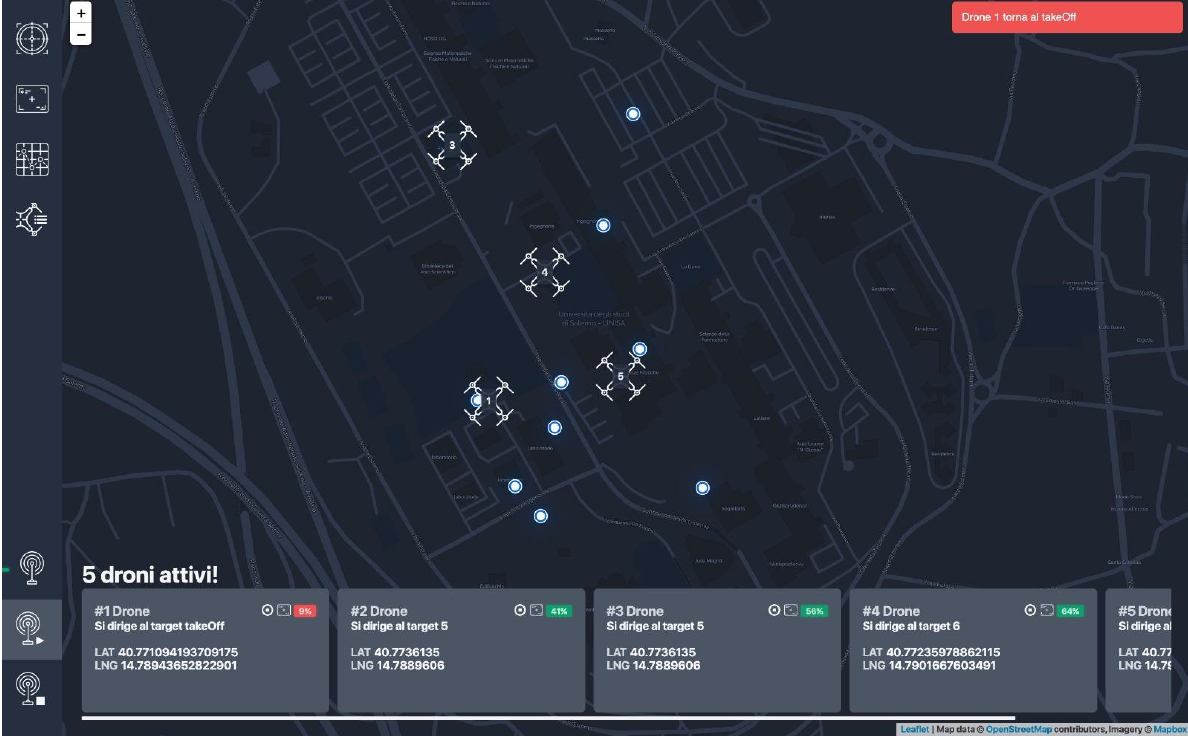
Figure 3. The GCS interface during the mission execution in case the drone battery is ≤ 10%.